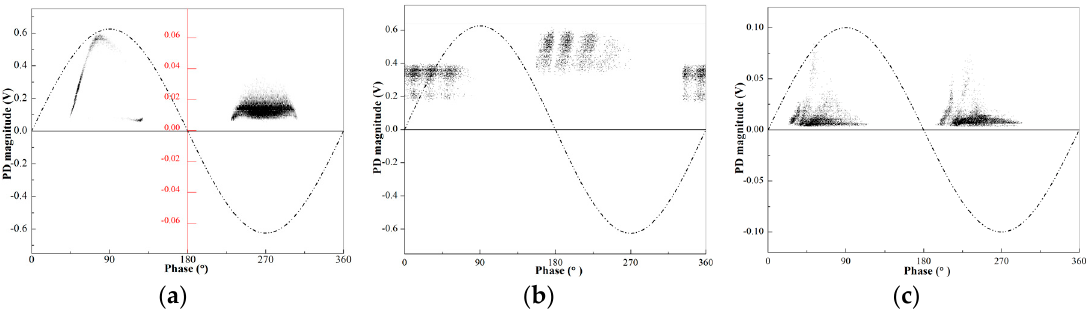
Figure 18. Corresponding grayscale images of PRPD diagram: ( a ) needle-plate discharge; ( b ) floating potential discharge; and ( c ) surface discharge.